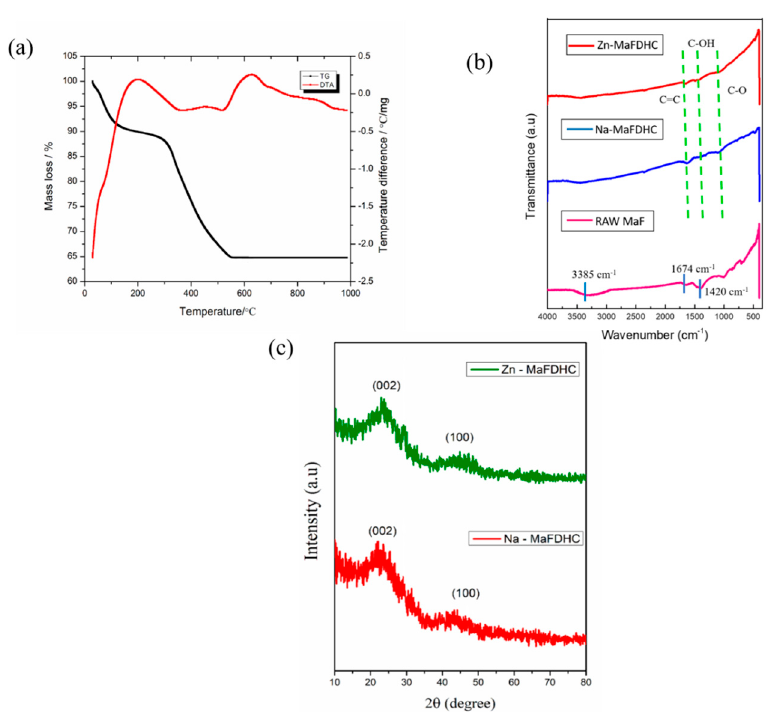
Figure 2. ( a ) TG/DTA of raw MaF. ( b ) FT − IR spectrum of Na − MaFDHC and Zn − MaFDHC, ( c ) XRD pattern of Na − MaFDHC and Zn − MaFDHC powders.